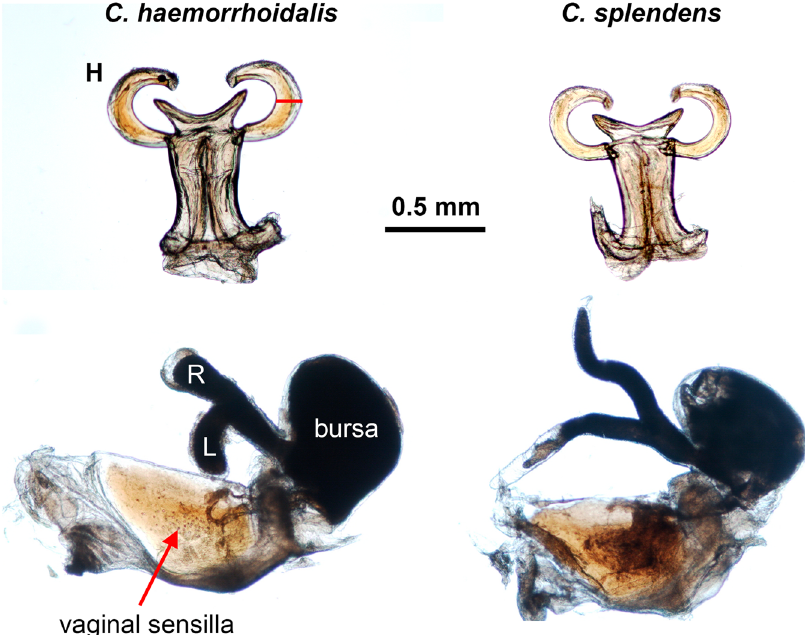
Figure 1. Male and female genitalia in C. haemorrhoidalis and C. splendens . The upper figures show the penis head in ventral view, with the lateral horns (H) used to remove sperm from the spermatheca. Note that the tri- dimensional position of the horns is not natural, because they were placed in a plane by a coverslip, to allow measuring their length. There were no significant differences between species in horn length (from the basis to the tip) and width (measured as indicated by the red segment on the middle of the horn). The lower figures show the female genital tract and sperm storage organs of mated females at the same scale as male genitalia. The sperm stored is the dark mass inside the bursa and the spermathecae. The spermathecae (L = left, R = right) were significantly longer in C. splendens , suggesting this is a counter-adaptation to difficult male sperm removal from that organ. (Scale bar = 0.5 mm, common for all